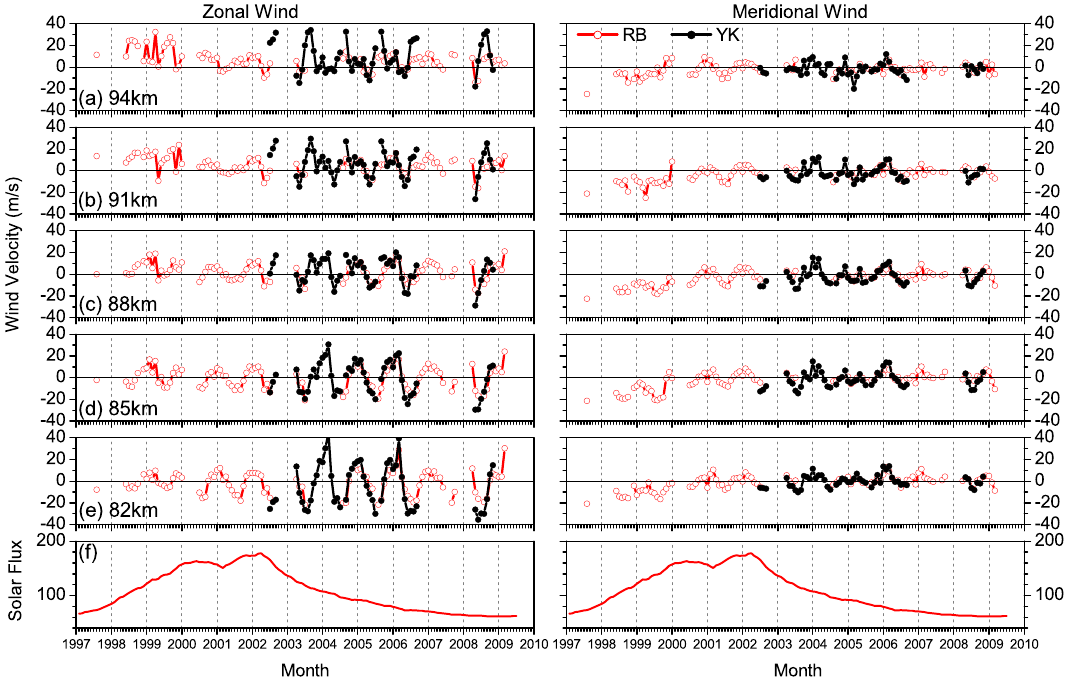
Fig. 3. (a–e) Monthly variation of the zonal and meridional winds over RB (red line with open circles) and YK (black line with filled circles) for the period 1997–2009 for heights 94, 91, 88, 85, and 82km, respectively. (f) Monthly variation of a 12 point smoothed monthly solar flux for the period